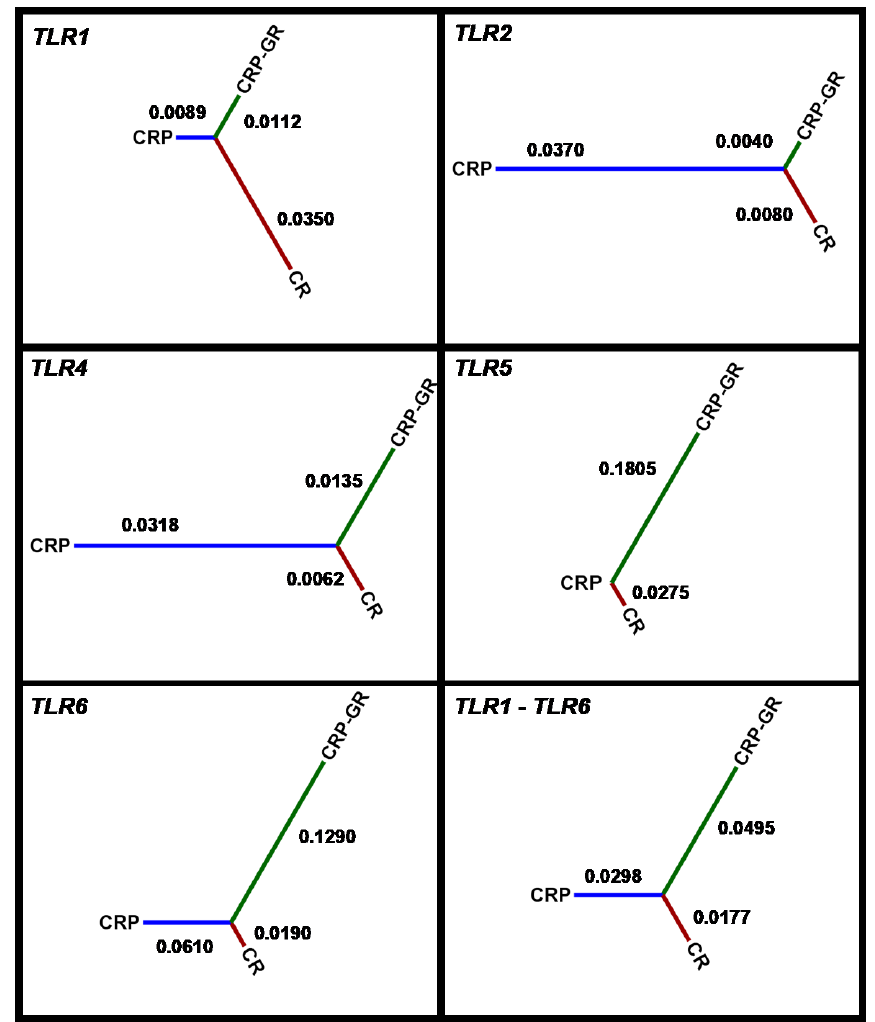
Figure 2. Inter-population distances based on all five TLR genes according to Nei’s standard distance measure. CRP – production population of Czech Red Pied cattle, CRP-GR – conserved subpopulation of Czech Red Pied in genetic resources, and CR – conserved Czech Red